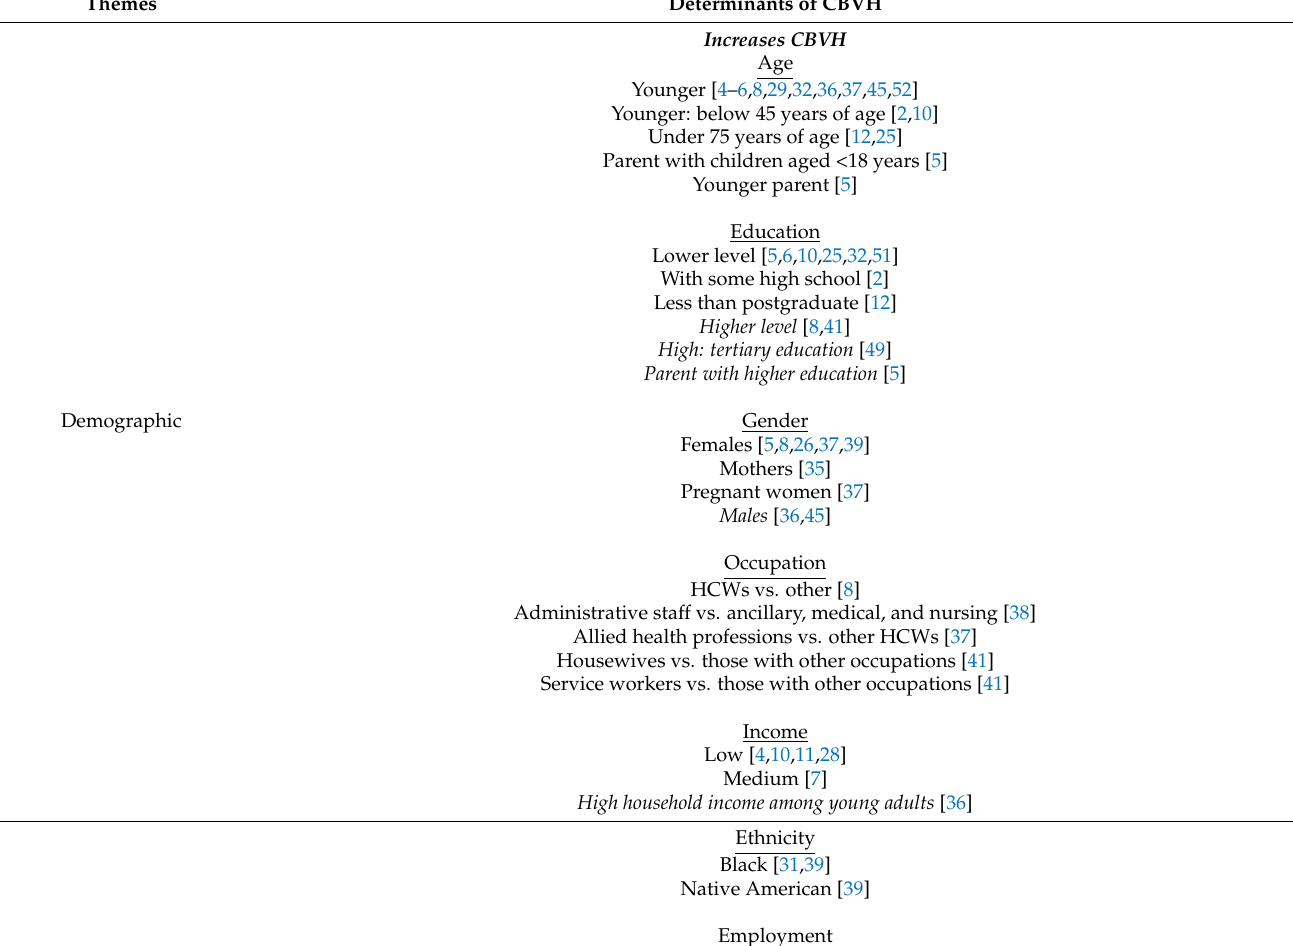
Table 3. Predictors of COVID-19 booster vaccination hesitancy by